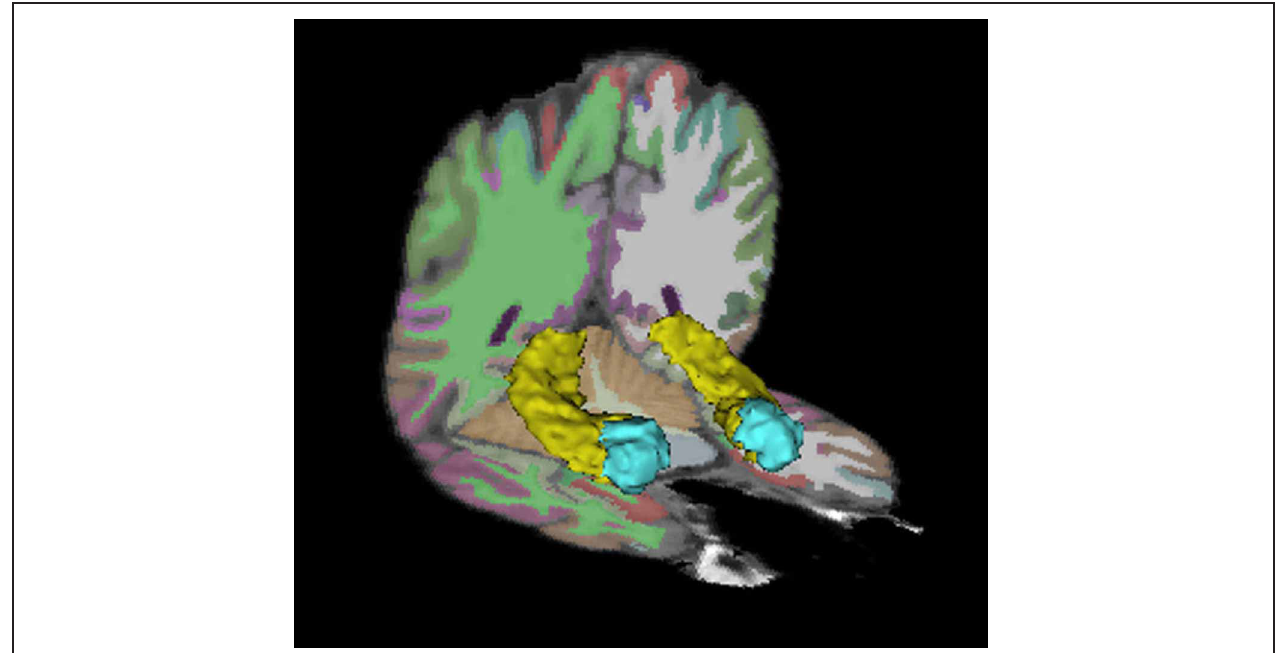
FIGURE 1 | Hippocampus and amygdala regions of interest. The bilateral hippocampi are depicted in yellow. The bilateral amygdalae are depicted in